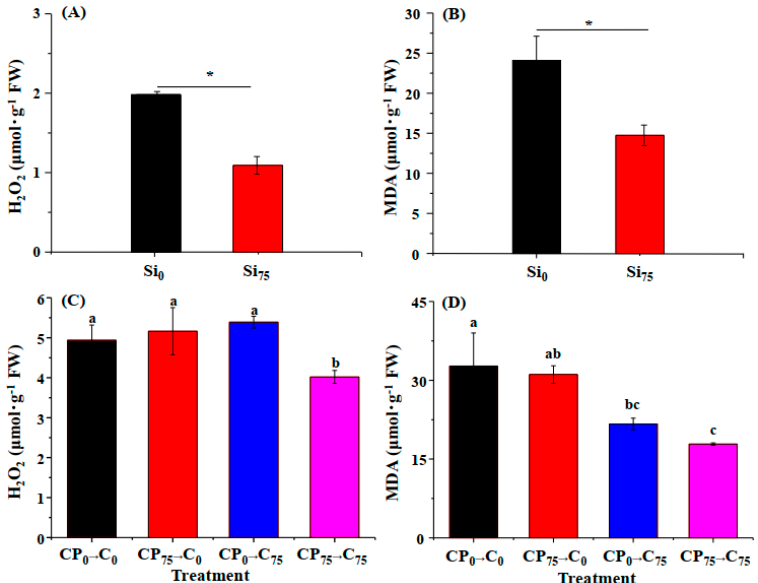
Figure 5. The MDA and H 2 O 2 concentrations in leaves of poinsettia subjected to high ( A , B ) and low ( C , D ) temperature stresses. The asterisk and different letters besides error bars indicate significant differences according to Student’s t -test and Duncan’s test, respectively ( p ≤ 0.05). Si 0 , 0 mg ∙ L − 1 Si; Si 75 , 75 mg ∙ L − 1 Si; CP 0 → C 0 , grown with 0 mg ∙ L − 1 Si during cutting propagation and cultivation; CP 75 → C 0 , grown with 75 mg ∙ L − 1 Si during cutting propagation and 0 mg ∙ L − 1 Si during cultivation; CP 0 → C 75 , grown with 0 mg · L − 1 Si during cutting propagation and 75 mg · L − 1 Si during cultivation; CP 75 → C 75 , grown with 75 mg · L − 1 Si during cutting propagation and 75 mg · L − 1 Si during